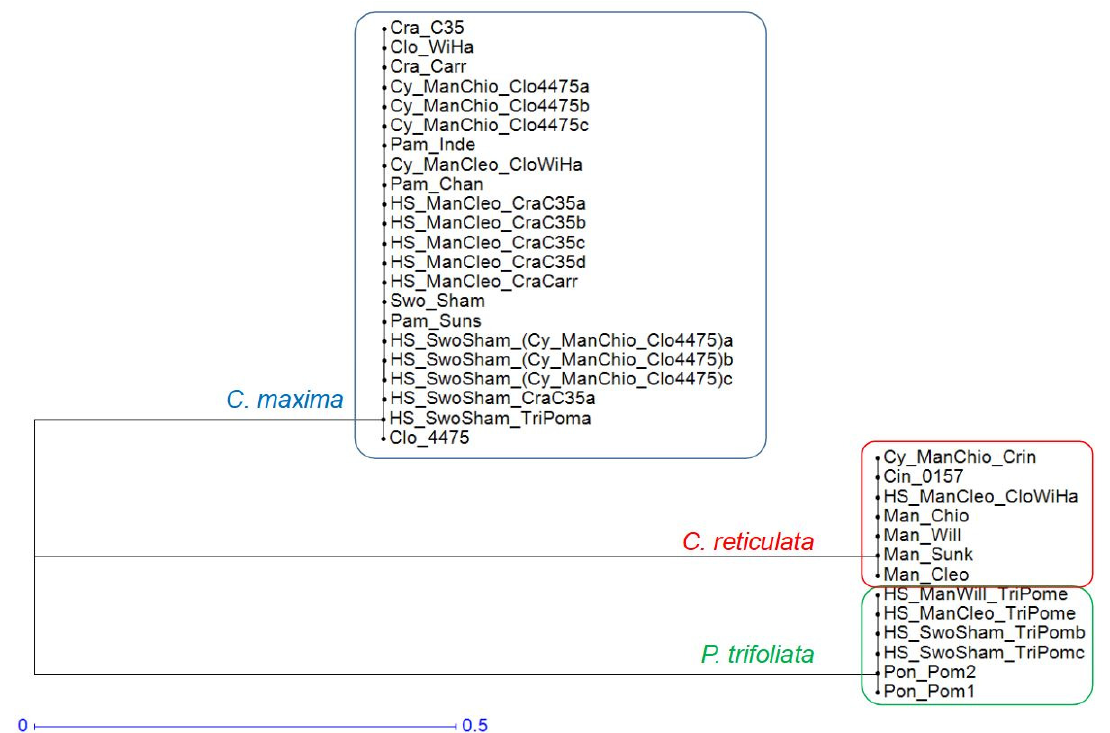
Figure 4. Inheritance of chloroplastic genomes: NJ tree inferred from four diallelic SNPs.